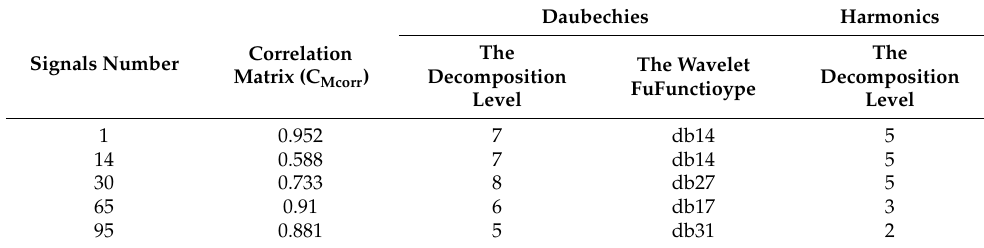
Table 2. C Mcorr evaluation criterion performance comparison.